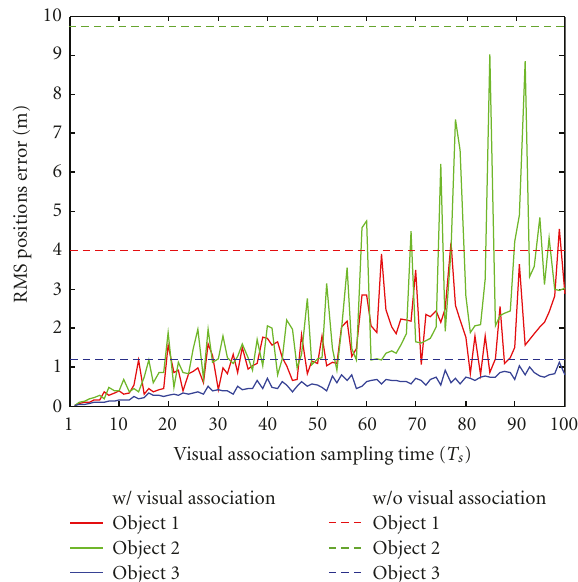
Figure 5: RMS position error for periodic cooperation with T v : 1 T s to 100 T s . (500 particles are used in the